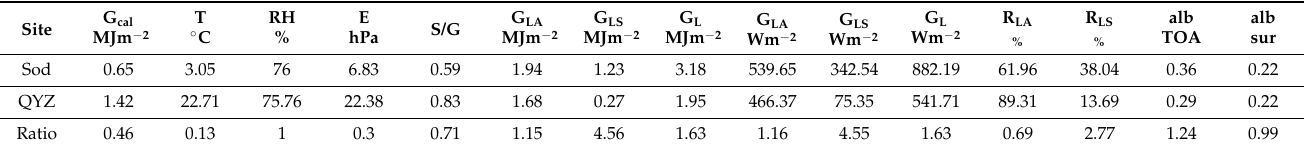
Table 5. Annual averages of monthly global solar irradiance and other variables at Sodankylä (refer to as Sod) and QYZ sites during 2013–2016, and the ratios of all parameters between Sodankylä and QYZ (alb and sur denote albedo and surface,